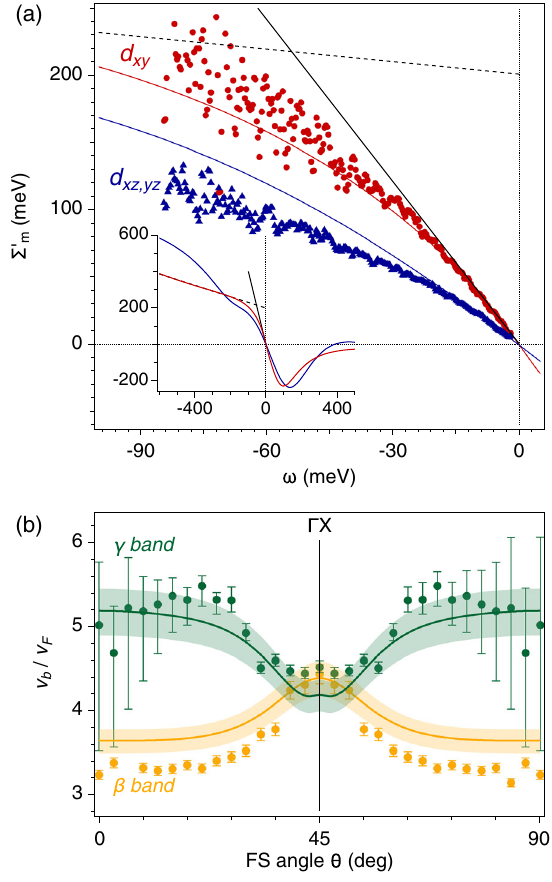
FIG. 6. (a) Average of the self-energies Σ 0 , Σ 0 shown in xy xz=yz Fig. 4(d) compared with DMFT self-energies calculated at 29 K. ω ¼ 0 Þ ¼ 0 . The inset The self-energies are shifted such that Σ 0 m ð shows the DMFT self-energies over a larger energy range. Linear fits at low and high energies of Σ 0 from DMFT are shown as xy solid and dashed black lines, respectively. (b) Angle dependence =v of the mass enhancement v from ARPES (markers) and b F DMFT (solid line). The range indicated by the shaded areas corresponds to mass enhancements calculated from the numerical data by using different methods (see Appendix B 2). Error bars on the experimental data are obtained from propagating the esti- mated uncertainty of the Fermi velocities shown in Fig.